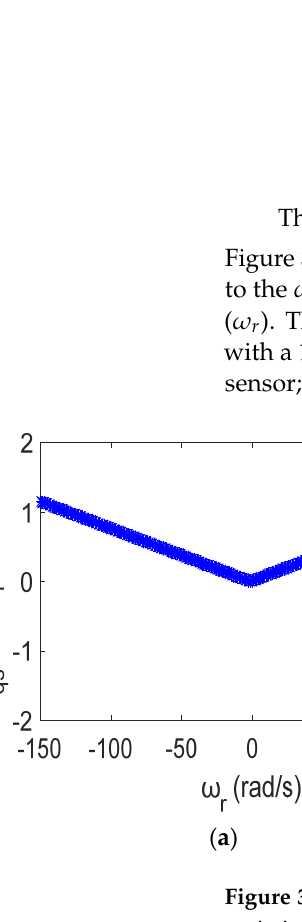
(cid:3162)(cid:3177)(cid:3163) ∆ i e with respect to the ds ∆ with respect to the ω r ∆(cid:2985) (cid:3176) ω r